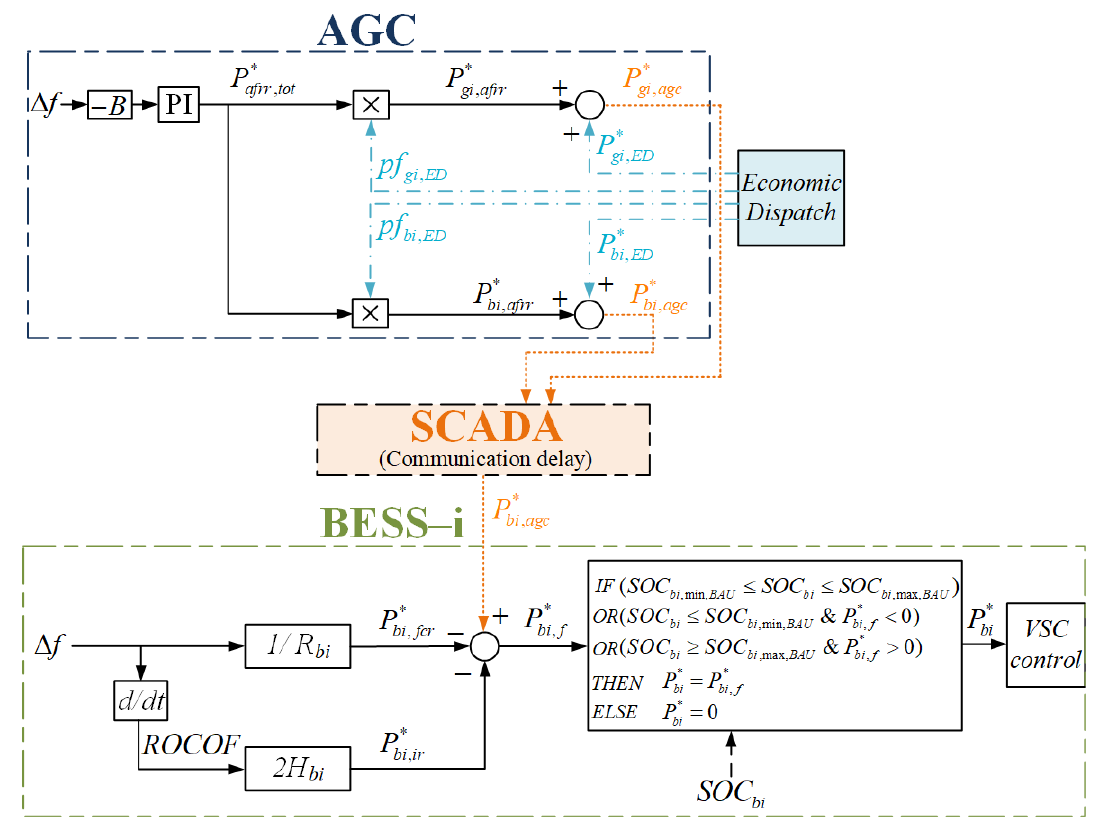
Figure 5. BAU state of charge (SOC) control scheme.